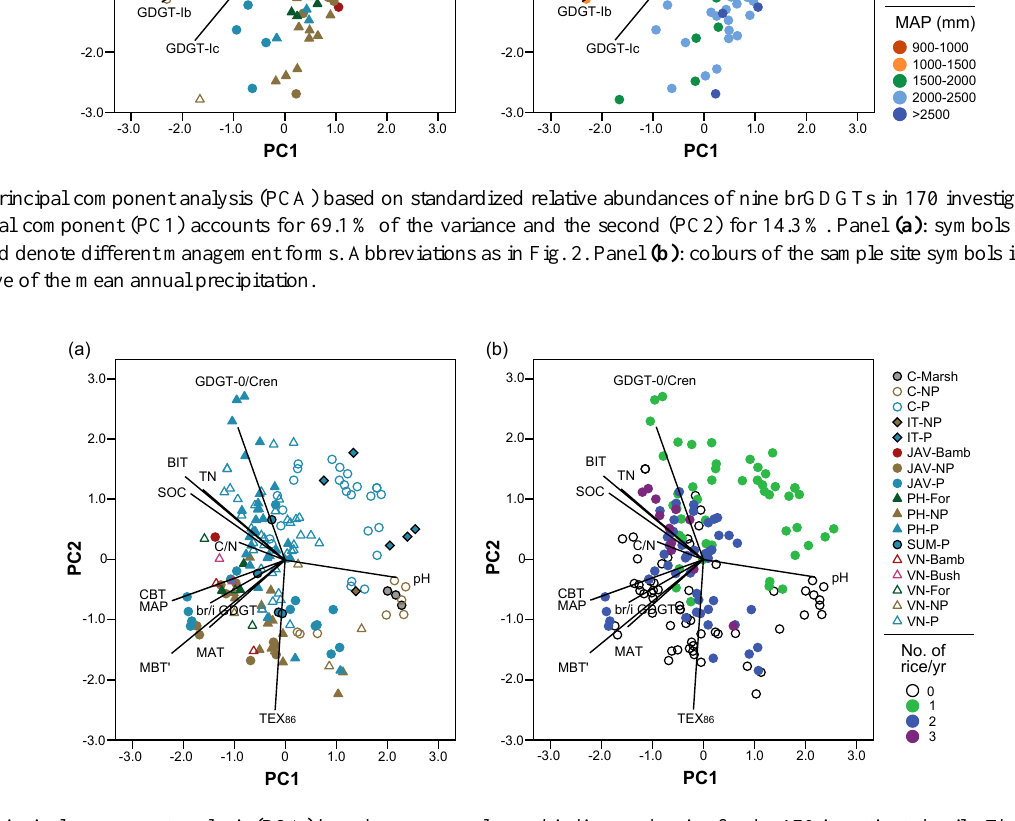
Figure 9. Principal component analysis (PCA) based on commonly used indices and ratios for the 170 investigated soils. The first principal component (PC1) accounts for 33.5% of the variance and the second (PC2) for 21.4%. Panel (a) : symbols and colours in upper legend denote different management forms. Abbreviations as in Fig. 2. Panel (b) : colours of the sample site symbols in lower legend are indicative of the number of rice cultivation cycles per year (“No. of riceyr − 1